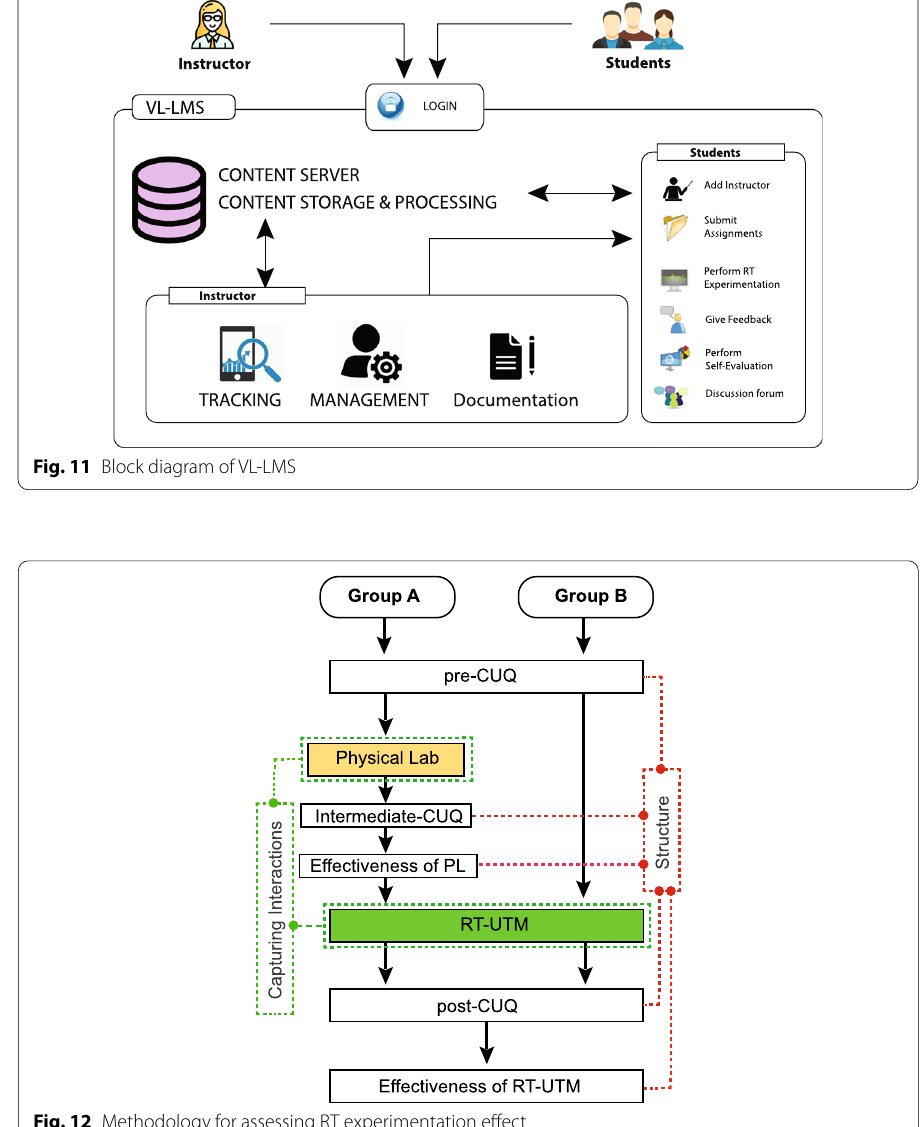
Fig. 12 Methodology for assessing RT experimentation